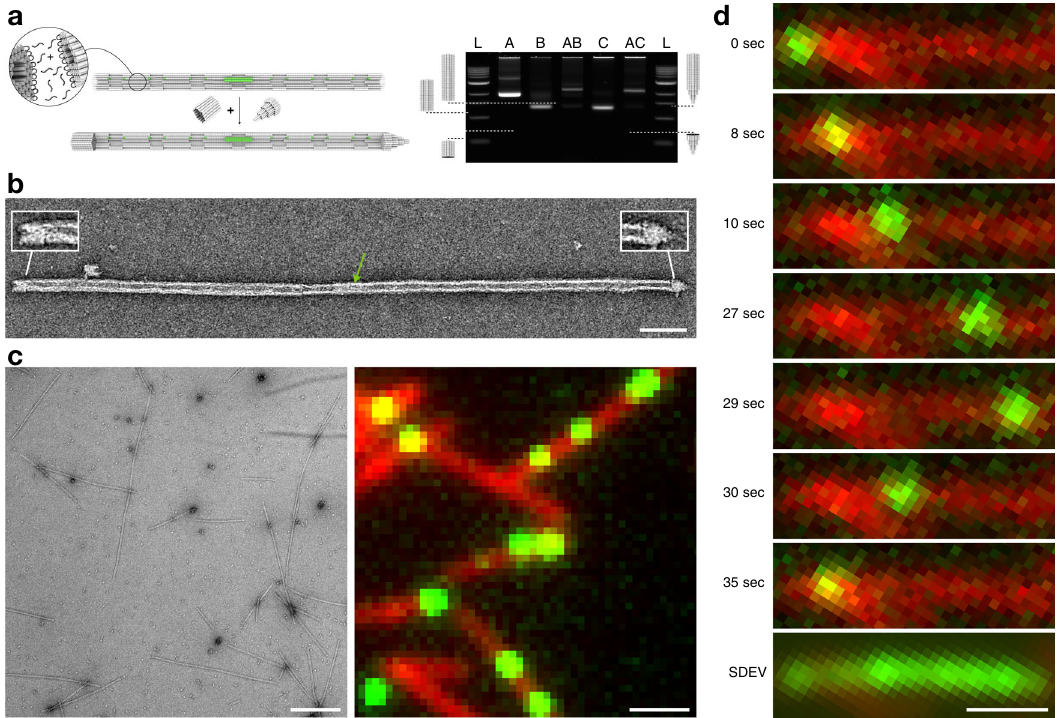
Fig. 3 Filament polymerization, capping, and single-particle imaging. a Left: Schematic illustration of the polymerization reaction and subsequent capping of the fi lament ends. Filament polymerization is induced by addition of DNA oligonucleotides that bridge barrel monomer helical interfaces. Subsequently, capping objects are added to solution which feature single-stranded DNA overhangs complementary to barrel ends. Cap attachment quenches further polymerization. The piston (green object inside the fi lament) is now sterically trapped. Right: Laser-scanned image of an agarose gel (2%, 21 mM MgCl 2 , 90 V, 90 min, ice-water bath) on which the following samples were electrophoresed: L = 1 kb ladder, A = closed barrel, B = capping object, AB = closed barrel-capping object 1 dimers, C = closed barrel-capping object 1 dimers, C = capping object 2, AC = closed barrel-capping object 2 dimers. The